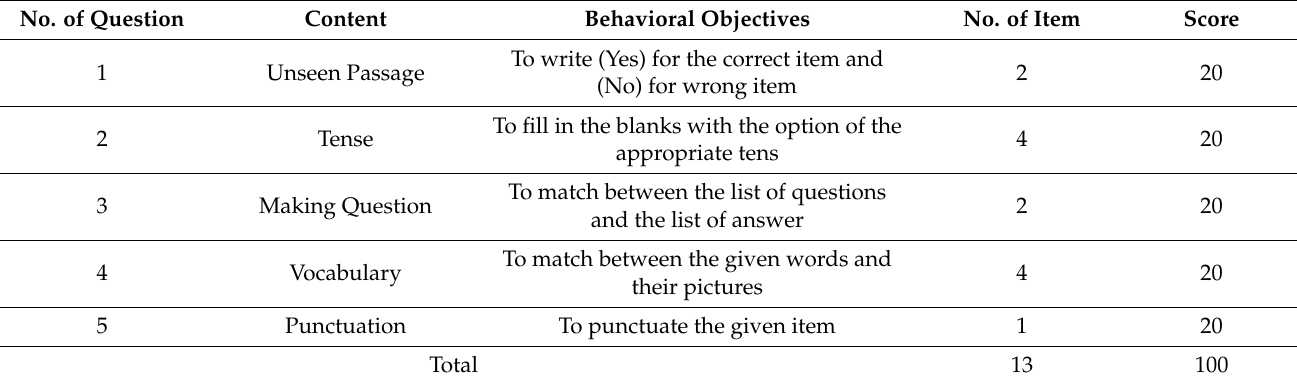
Table 9. The Specifications of the Contents, Behaviors, and Scores of the Three